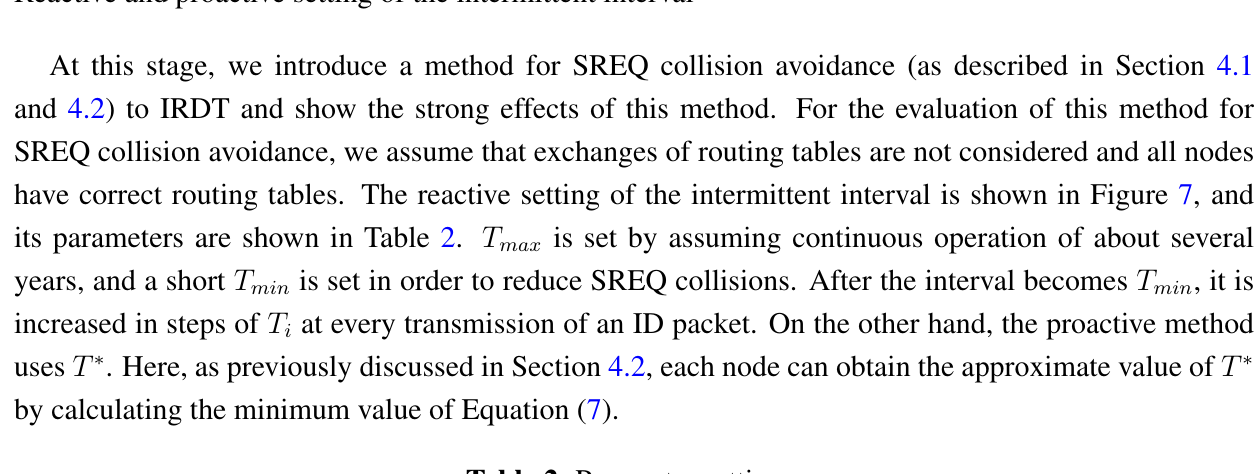
Table 2. Parameter